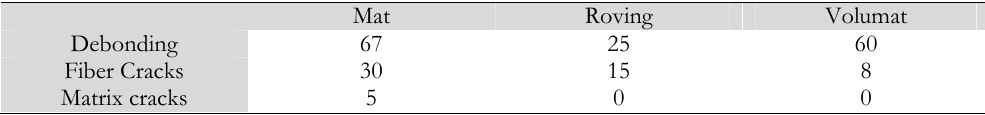
Table 3: Defect count in the fatigued run-out